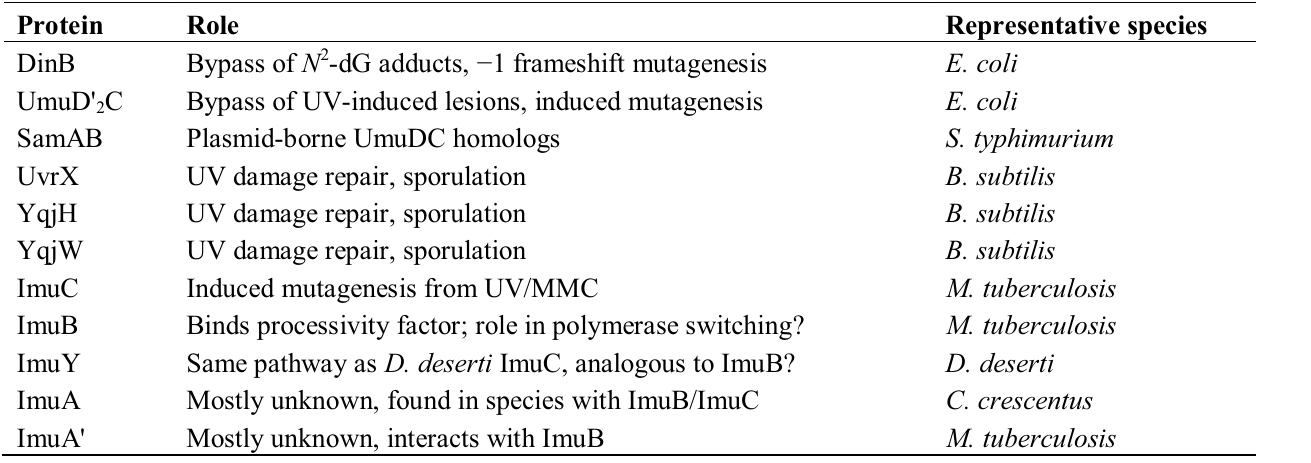
Table 2. Summary of DNA polymerases and their accessory factors. For each protein, a species that contains the most studied or most representative protein is listed.